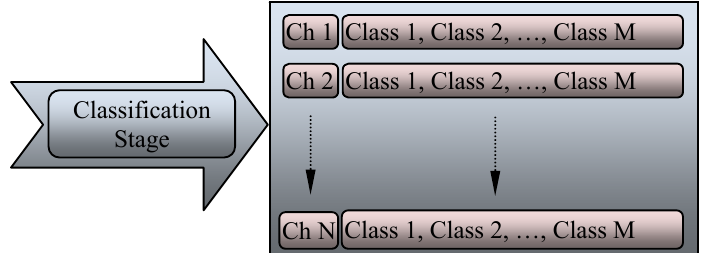
Figure 11. The classification stage for multiple